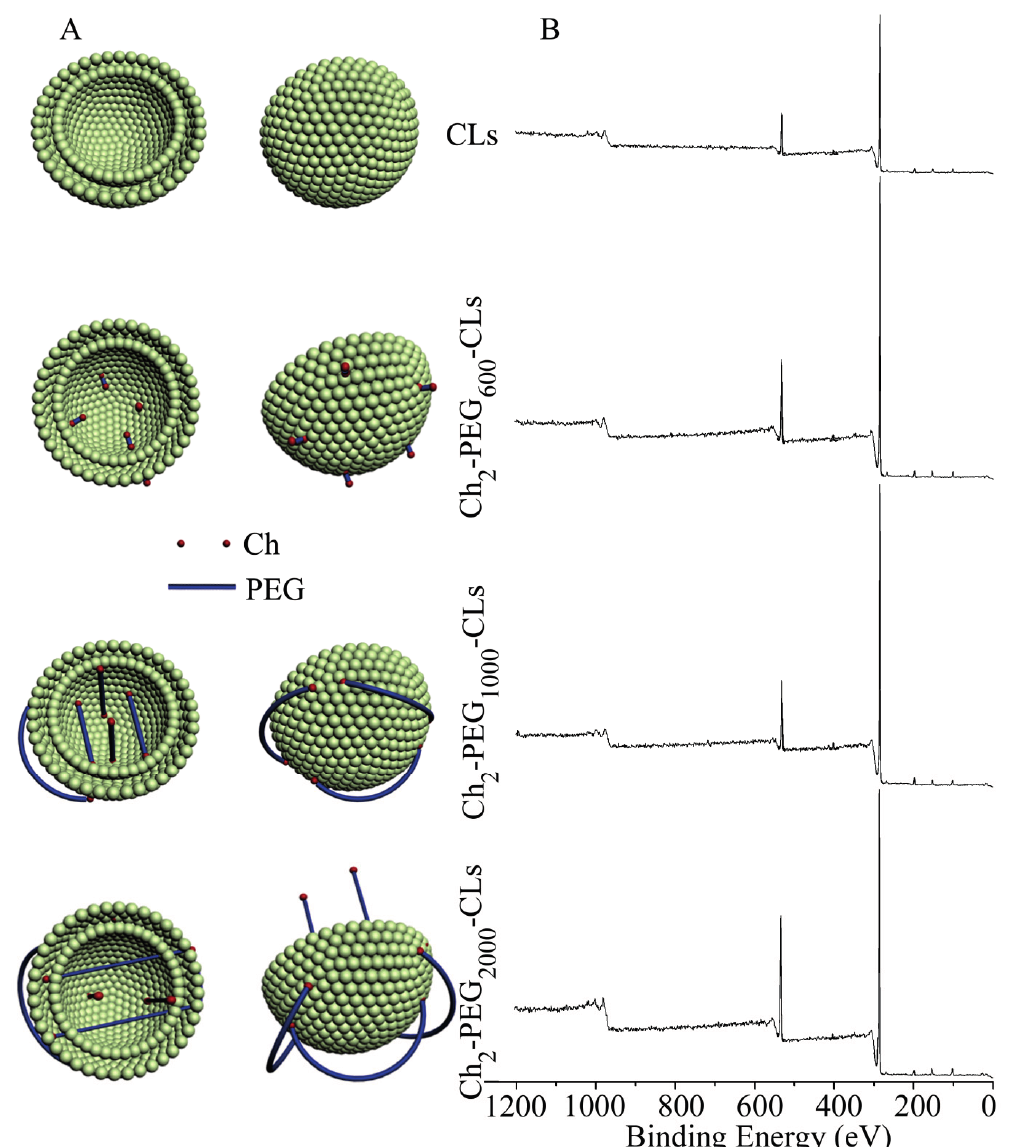
Figure 4. Schematic diagram and XPS analysis of Ch 2 -PEG n -CLs. ( A ) Ch segments of Ch 2 -PEG n anchored into the lipid bilayer of CLs. Due to the short PEG chain, Ch 2 -PEG 600 did not effectively shield the charge of CLs. Ch 2 -PEG 1000 and Ch 2 -PEG 2000 decreased the positive charge by covering the surface of CLs. With longer PEG chains, Ch 2 -PEG 2000 compressed the liposomal particle and therefore Ch 2 -PEG 2000 -CLs showed a smaller particle size; ( B ) XPS analysis demonstrated that more PEG segments were located on the surface of liposomes when PEG molecular weight